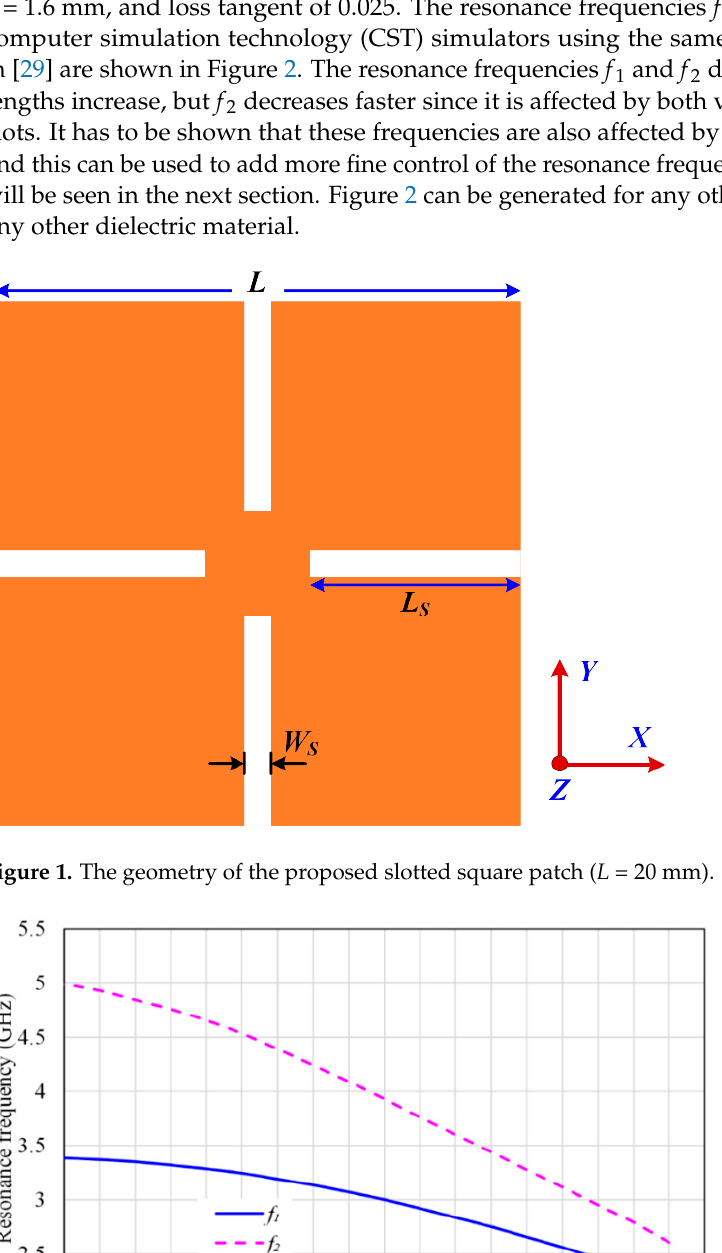
Figure 1. The geometry of the proposed slotted square patch ( L = 20 mm).